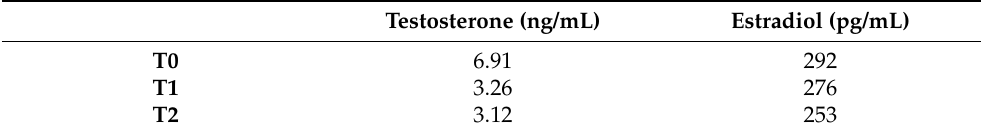
Table 2. Serum concentration of testosterone and estradiol, measured with chemiluminescence. T0, before Surgery; T1, 3 days after surgery; T2, 5 days after